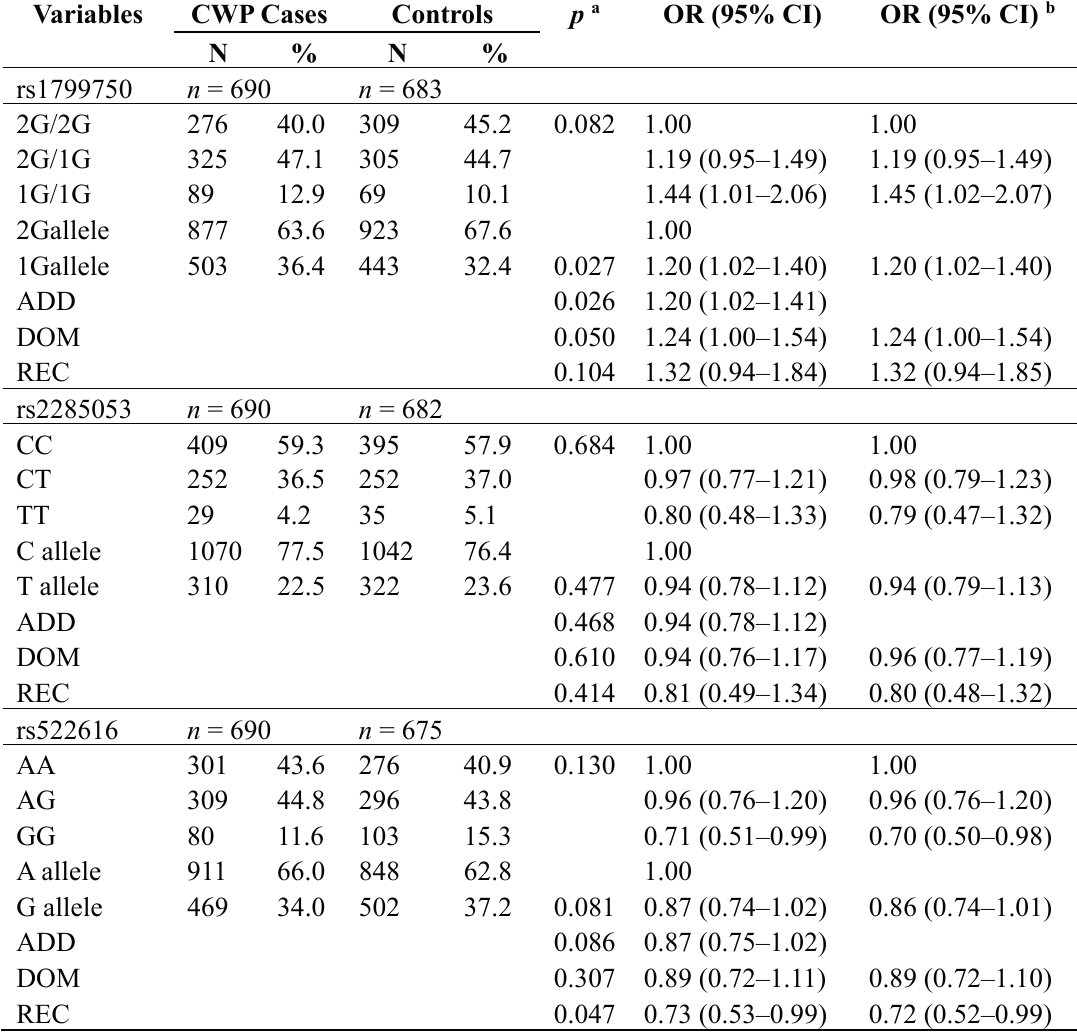
Table 3. Distributions of genotypes of and their associations with risk of